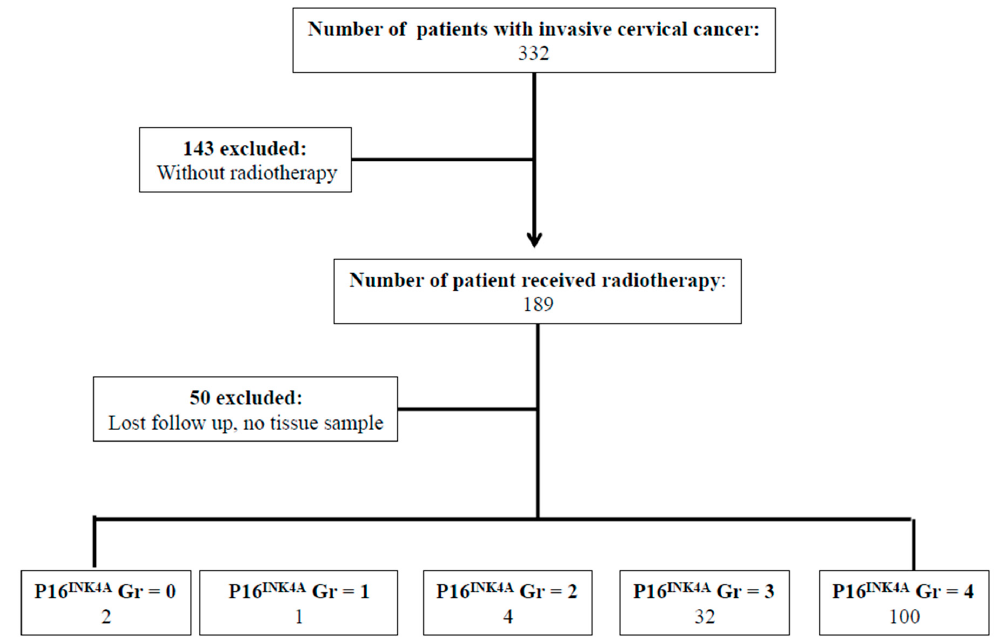
Figure 1. Flowchart of our retrospective study design. Every tumor was given a score according to the extent of stained cells nucleic staining of P16 INK4A expression (0% = 0, 1–10% = 1, 11–50% = 2, 51–80% = 3, 81–100% = 4). Abbreviations: Gr: grade.